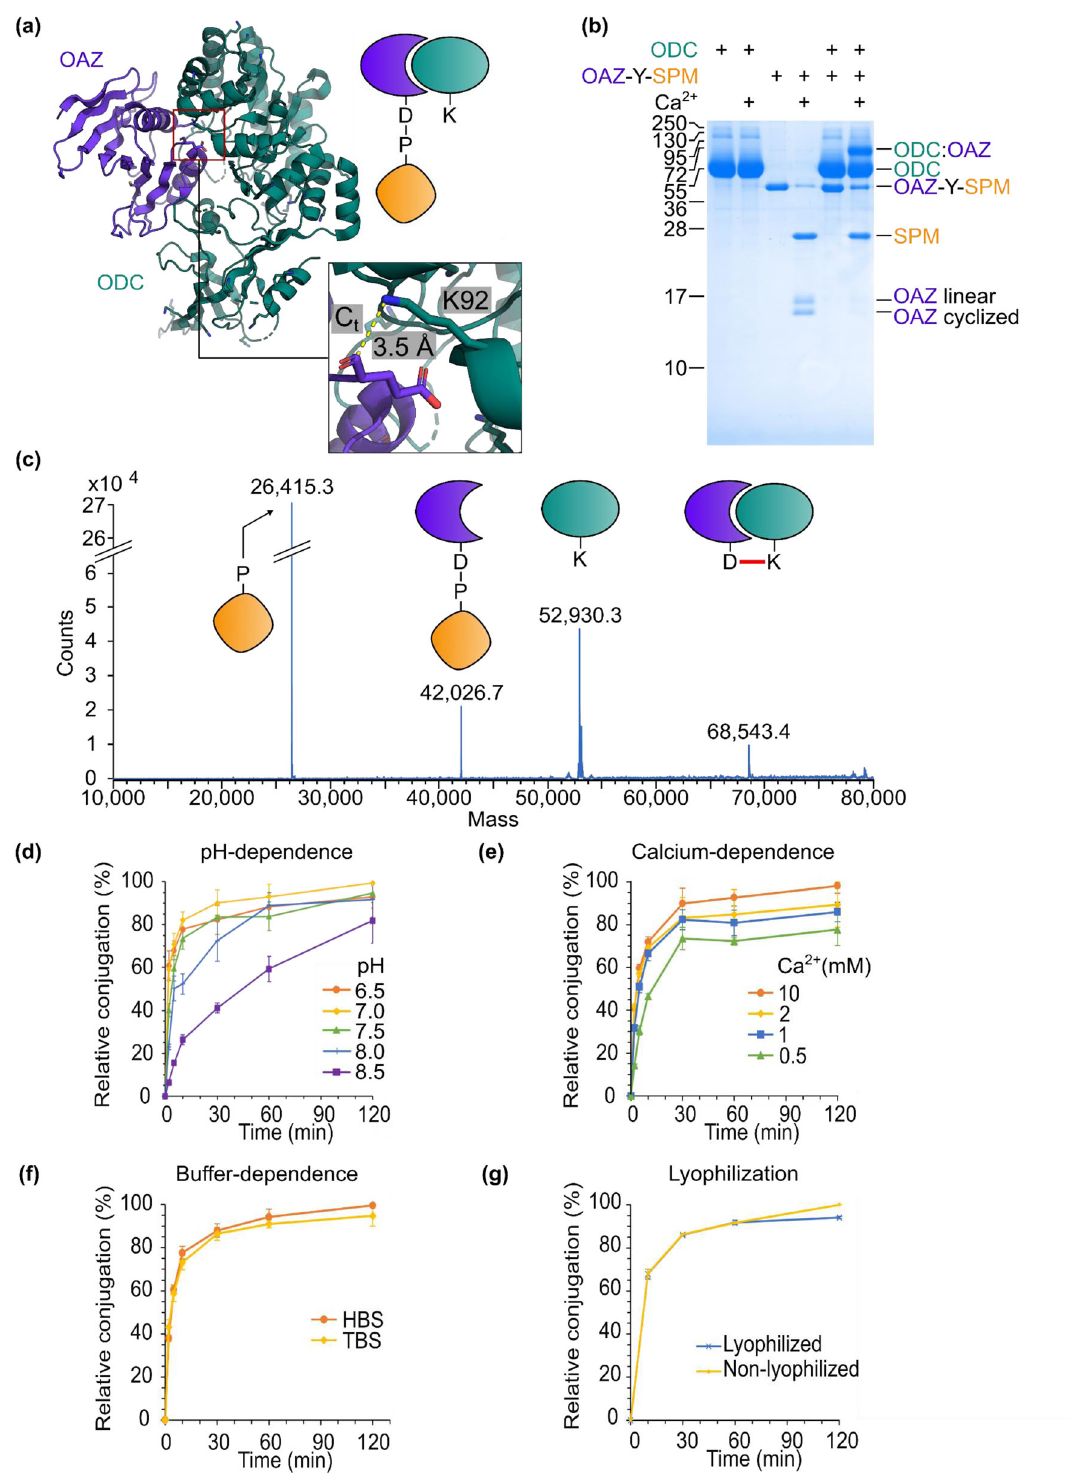
Fig. 3 Establishment of covalent bond formation by NeissLock. a Crystal structure of ODC/OAZ complex (PDB 4zgy). Inset shows the proximity from K92 of ODC to the C-terminal carbonyl carbon of OAZ, close to where the anhydride should be. b ODC reacted covalently with OAZ. 30 µ M ODC and 10 µ M OAZ-Y-SPM were incubated for 16 h with or without Ca 2 + , boiled in SDS-loading buffer, and analyzed by SDS-PAGE with Coomassie staining. Molecular weight markers represent kDa. c Intact protein electrospray ionization MS con fi rms covalent coupling of OAZ to ODC. Analysis of products from incubation of ODC with OAZ-Y-SPM in the presence of Ca 2 + . d pH-dependence of conjugation. OAZ-GSY-SPM was incubated with ODC and Ca 2 + at the indicated pH (compared to pH 7.0 at 120 min). e Calcium-dependence of conjugation. OAZ-GSY-SPM was incubated with ODC and Ca 2 + at the indicated concentrations (conjugation relative to 10 mM Ca 2 ). f Buffer-dependence of conjugation. OAZ-GSY-SPM was incubated with ODC at pH 7.4 and 10 mM Ca 2 + in HBS or TBS (conjugation relative to HBS). g Reactivity was unaffected by lyophilization. ODC was incubated with lyophilized or non-lyophilized OAZ-GSY-SPM. (All proteins 10 µ M at 37 °C and mean of triplicate ± 1 s.d.). Source data are provided as a Source Data fi le. NATURE COMMUNICATIONS| (2021) 12:717 |https://doi.org/10.1038/s41467-021-20963-5|www.nature.com/naturecommunications